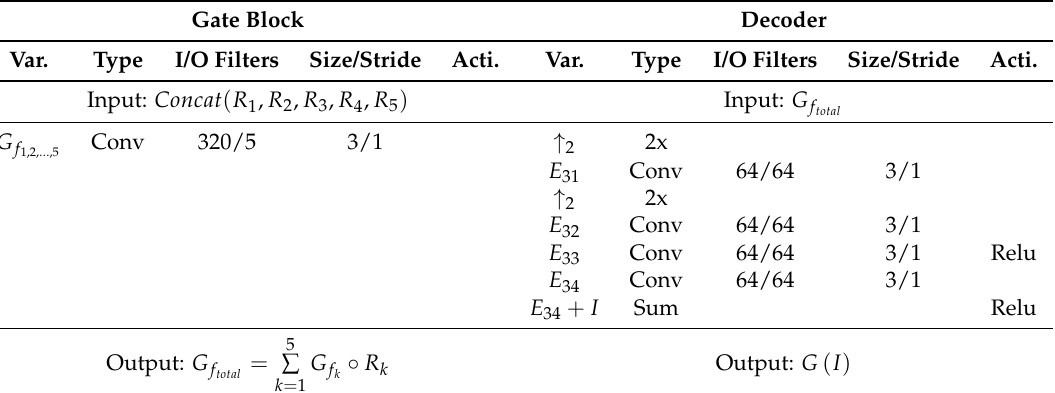
Table 2. Details of gate block and decoder.